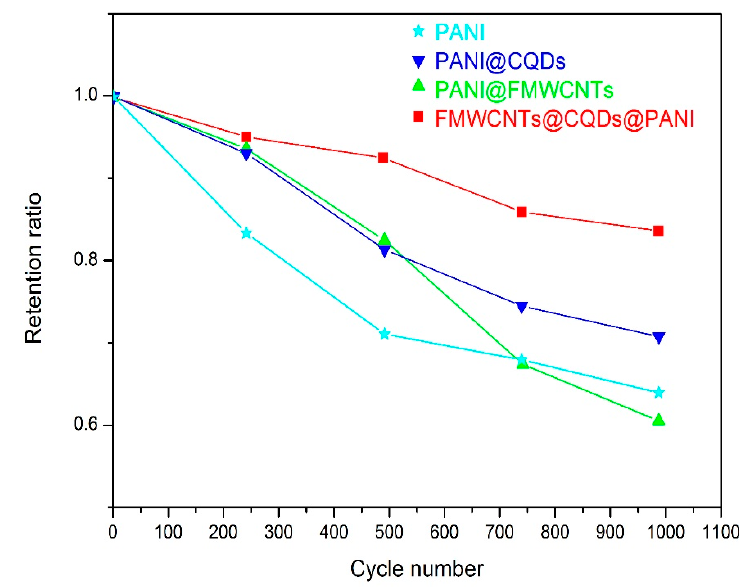
Figure 4. Retention rates of PANI, PANI @ CQDs, PANI @ FMWCNTs and FMWCNTs @ CQDs @ PANI under different number of cycles.